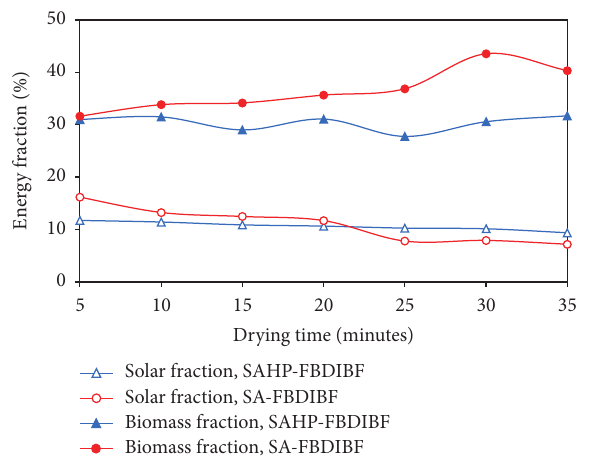
Figure 25: The variation of dimensionless moisture content with drying